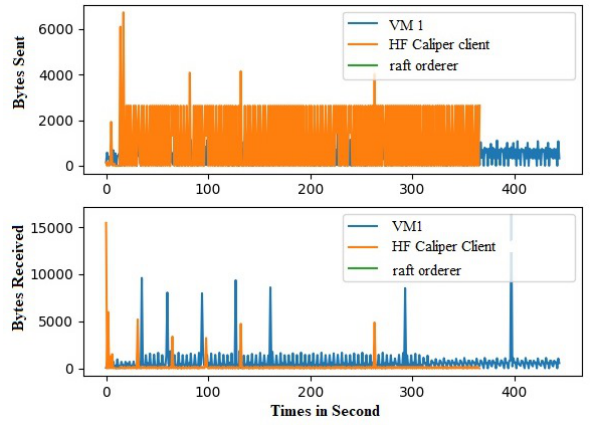
Figure 12. Transaction Traffic for VM